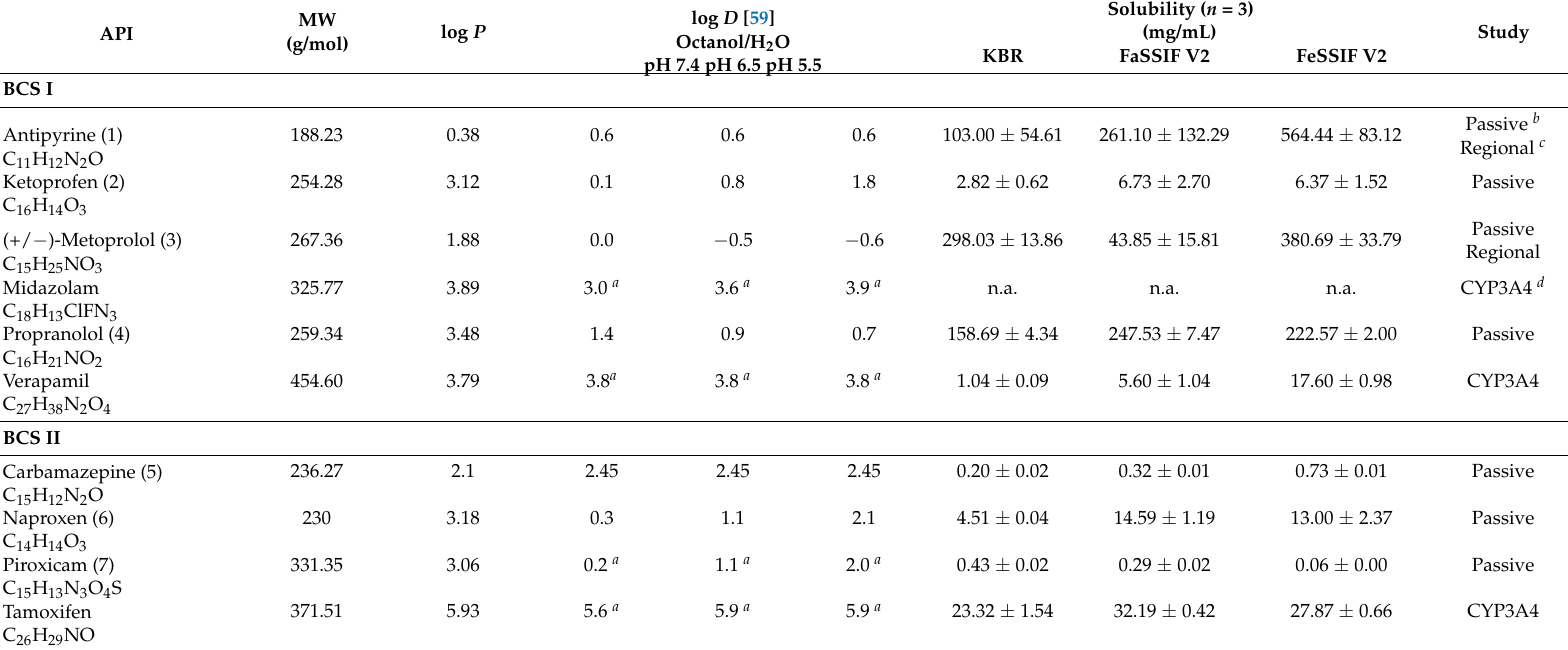
Table 1. The chemical structures and physicochemical properties of the drug molecules tested using the Ussing chamber